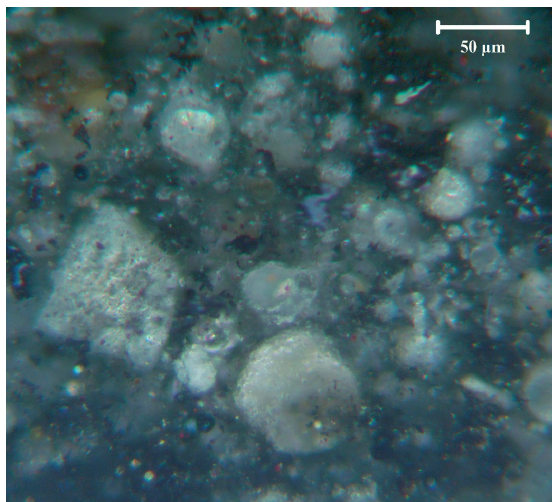
Figure 1. Plant W fly ash with both rounded and angular glass particles. Image 93932 FA 06.